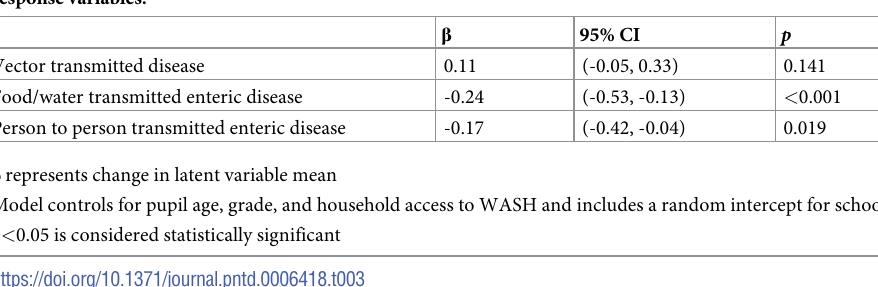
Table 4. Linear regression model results of the association between the school WASH intervention and antibody responses. Campylobacter jejuni (P18 Antigen)